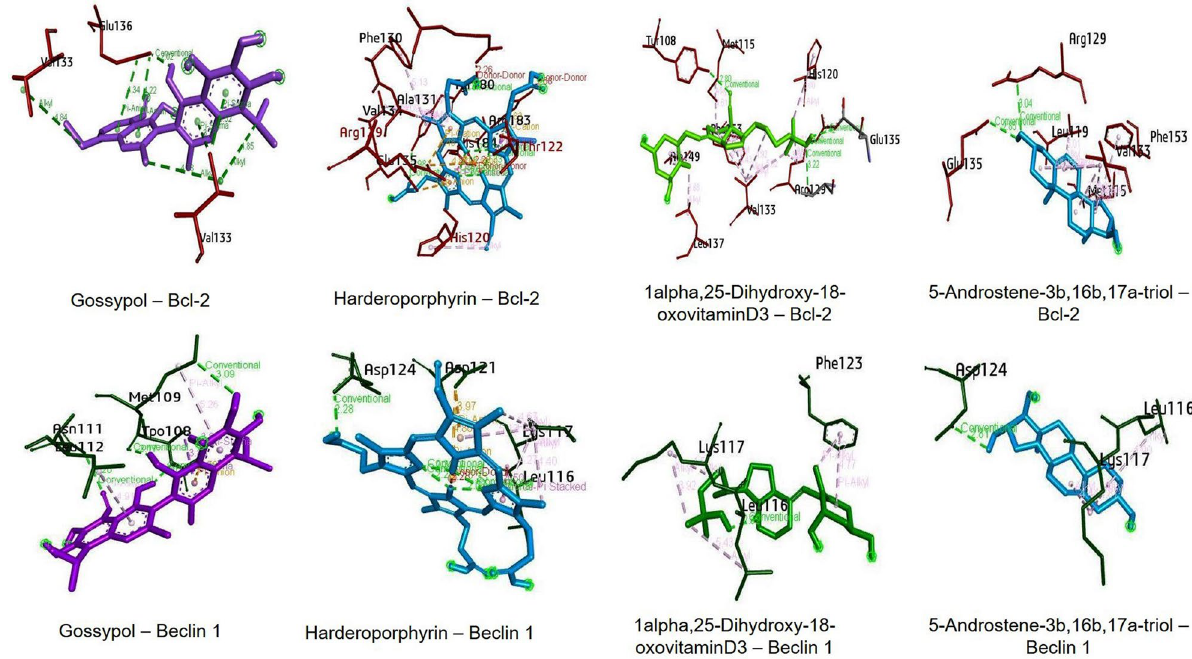
oxovitaminD3; 5-Androstene-3b,16b,17a-triol were purple, deep sky blue, green and cyan